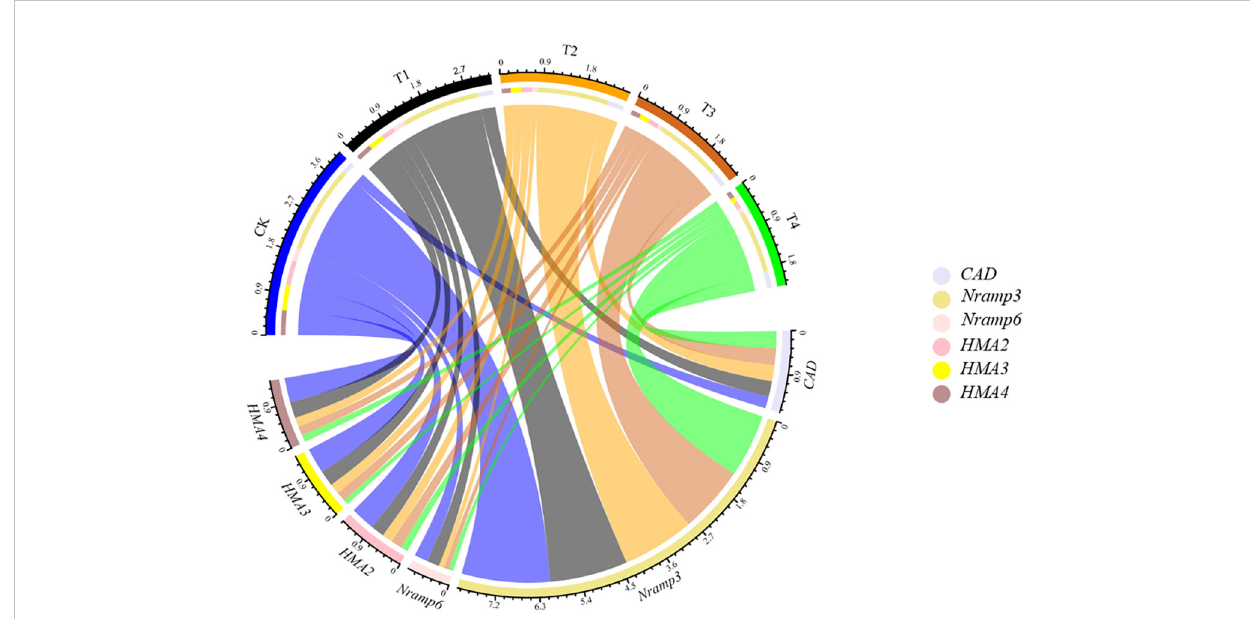
FIGURE 8 The expression level of related genes ( SaNramp3 , SaNramp6 , SaHMA2 , SaHMA3 , SaHMA4 and SaCAD ) in the root of S. alfredii under different Si treatments. CK: control treatment, T1, T2, T3 and T4 were the Si concentrations of 0.5, 1.0, 1.5 and 2.0 mmol ∙ L -1 ,